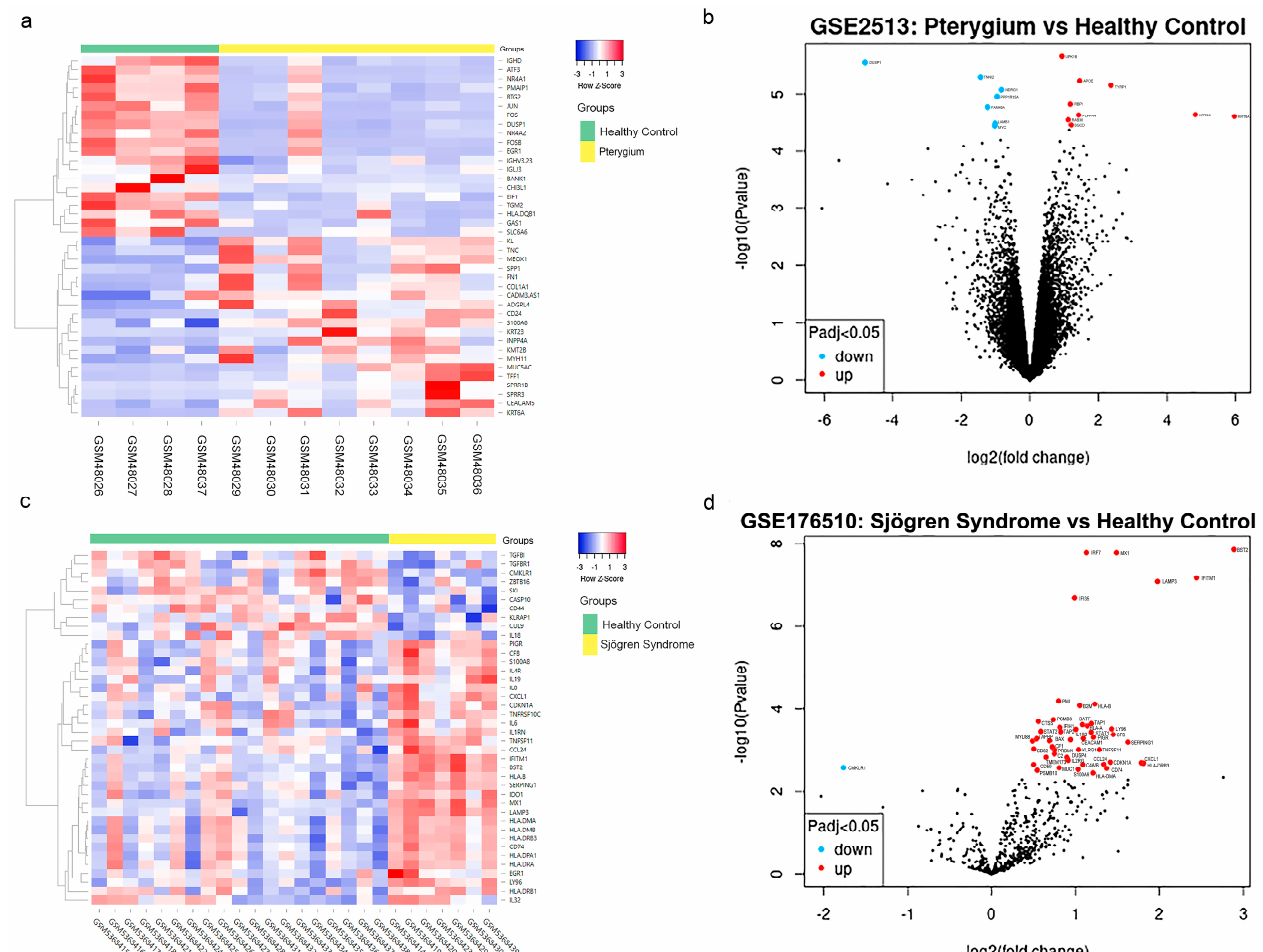
Figure 2. Identification of differentially expressed genes (DEGs) in pterygium and primary Sjögren Syndrome (pSS) samples. ( a ) Heatmap and ( b ) volcano plot of the DEGs between samples from pterygium and healthy control conjunctiva (GSE2513). ( c ) Heatmap and ( d ) volcano plot of the DEGs between samples from pSS and healthy control conjunctiva (GSE176510). Information about the dataset GSE2513 and GSE176510 is available in [Gene Expression Omnibus (GEO) database] at [https://www.ncbi.nlm.nih.gov/gds (accessed on 17 March 2022)]. DEGs between patients and healthy control conjunctiva were screened from the dataset using the classical Bayesian method with a threshold of p <